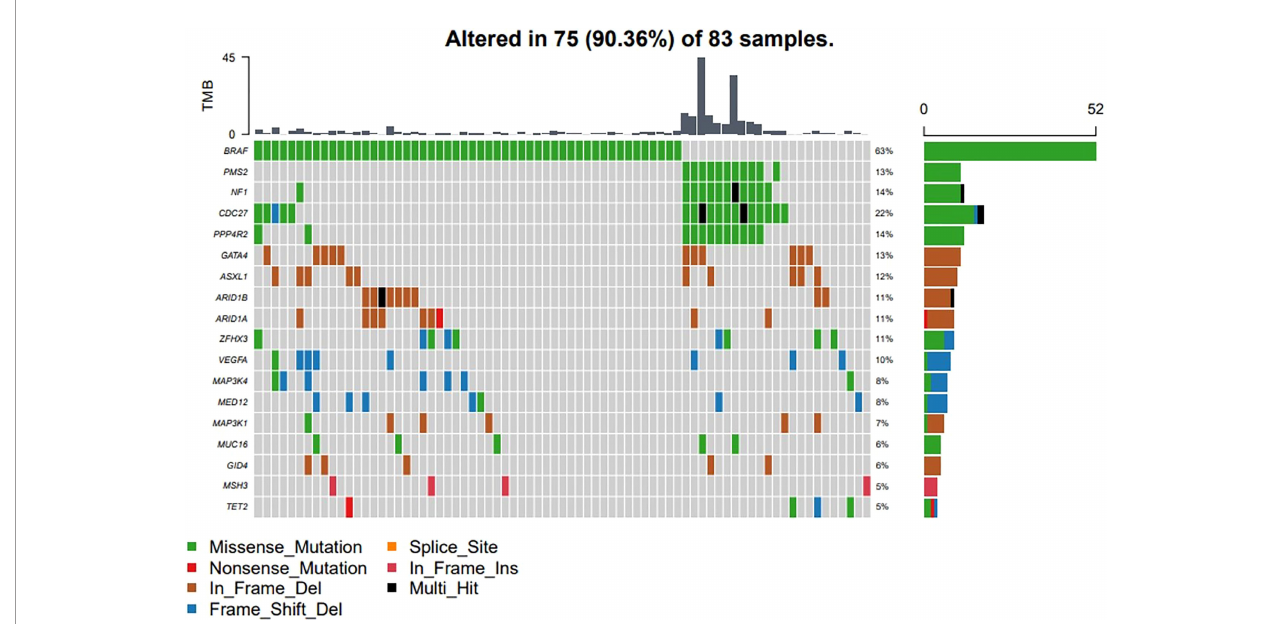
FIGURE 4 | Driver genes and clinical relevance. The driver events were classi fi ed into two major categories, the BRAF induced RAS-RAF-MEK-ERK signaling pathway, and the NF1 induced dysregulation of the RAS-RAF-MEK-ERK signaling